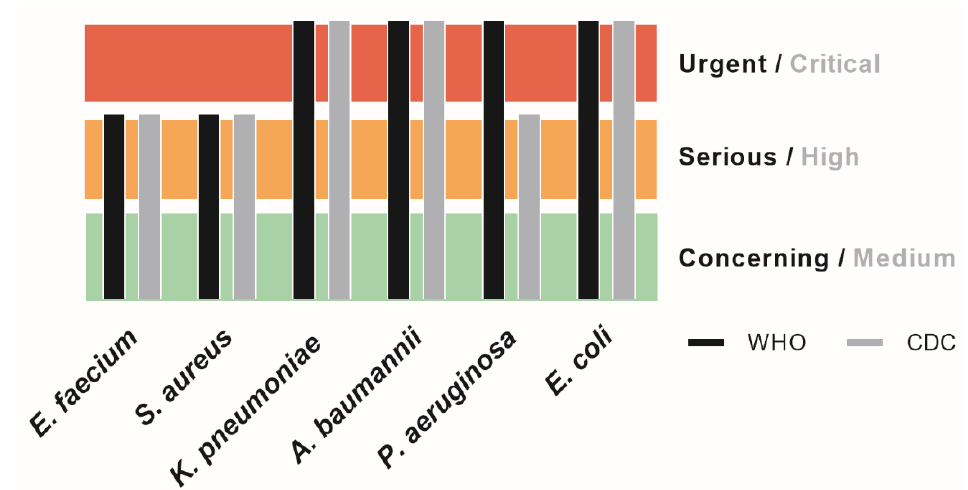
Figure 2. Priority list scaling for the ESKAPE pathogens according to both CDC and WHO.